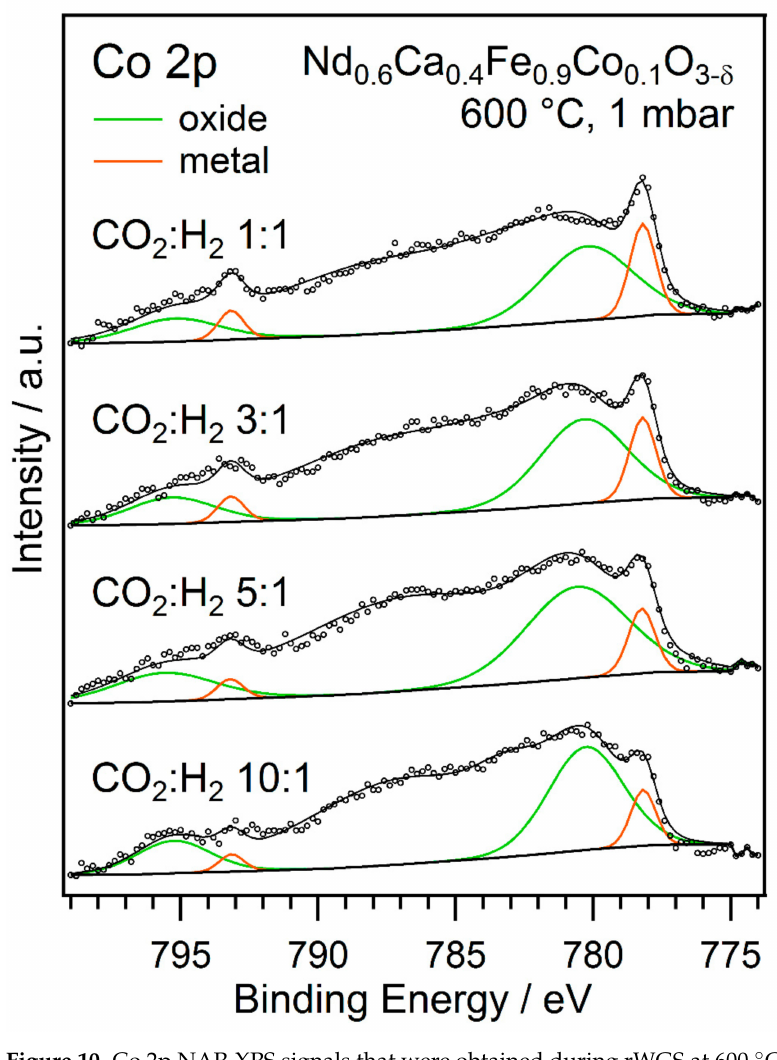
Figure 10. Co 2p NAP-XPS signals that were obtained during rWGS at 600 ◦ C with different ratios of CO 2 to H 2 . Metallic Co and Co-oxide contributions can be identified. The ratio of metallic Co to Co-oxide increases with lower CO 2 (and higher H 2 partial pressure), indicating a higher amount of reduced Co at the